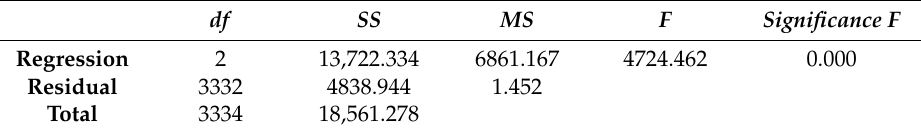
Table 7. Regression statistics and analysis of variance (ANOVA). df SS MS